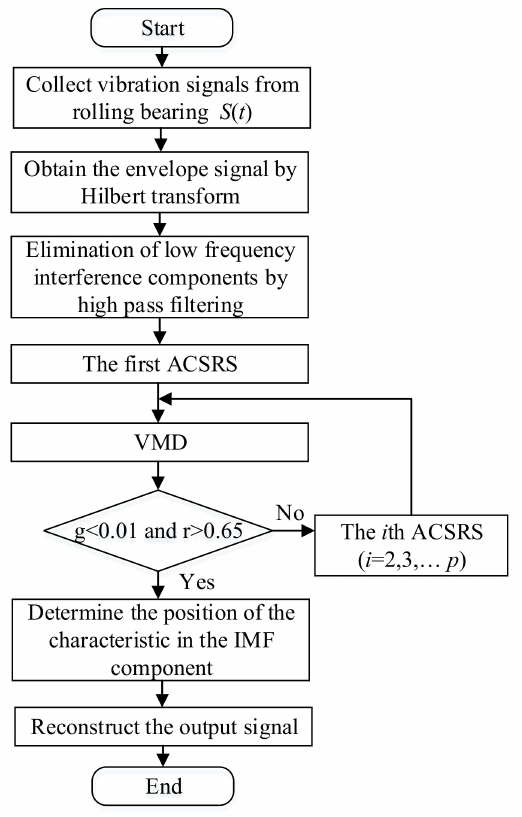
Figure 4. The method of multi-frequency weak signal decomposition and